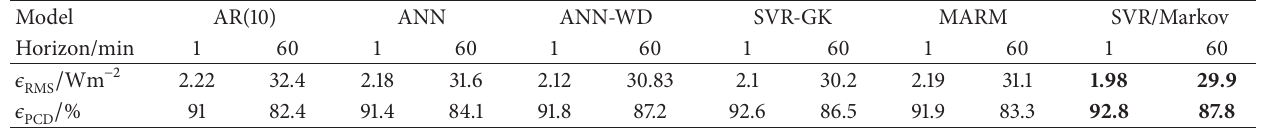
Table 10: Obtained average prediction values for ten days selected from October to November of 2000 ( autumn ).